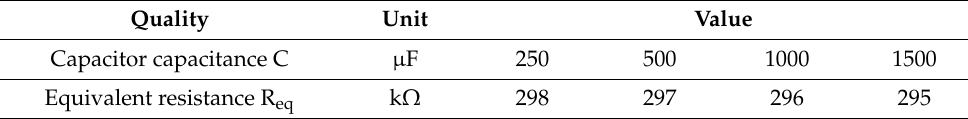
Figure 6. Course of voltage across the capacitors for discharging process. Values of the equivalent resistance R eq for each capacitor are presented in Table 2. Table 2. The equivalent resistance for storage and measurement